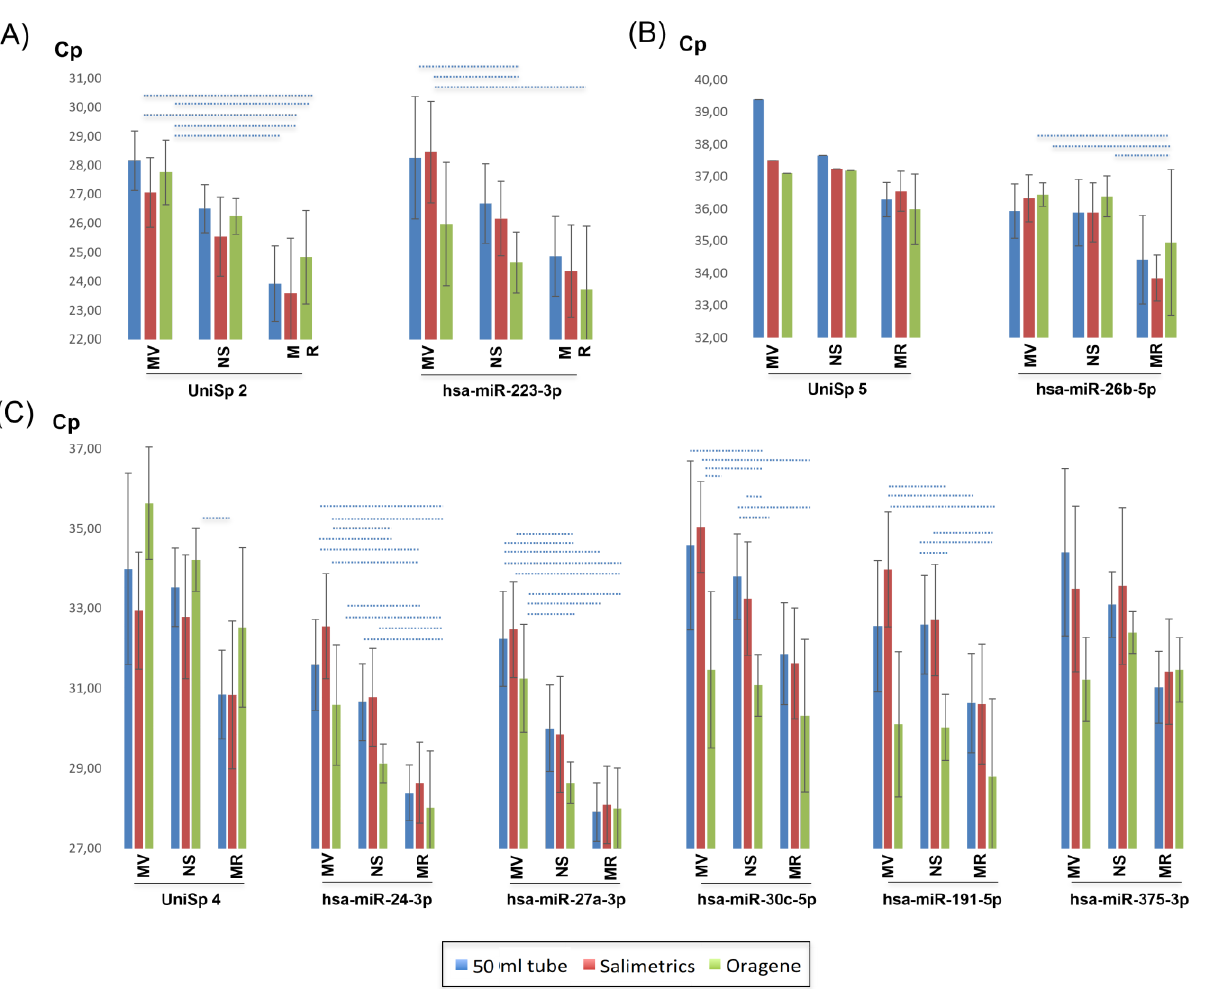
Figure 4. MiRNA expression levels are shown for all spike-in standards and hsa-miRNAs included in the study. ( A ): UniSp2 and hsa-miRNA with high expression, ( B ): UniSp5 and hsa-miRNA with low expression, ( C ): UniSp4 and hsa-miRNAs with intermediate expression. Dashed lines represent the most significant differences, p < 0.001.